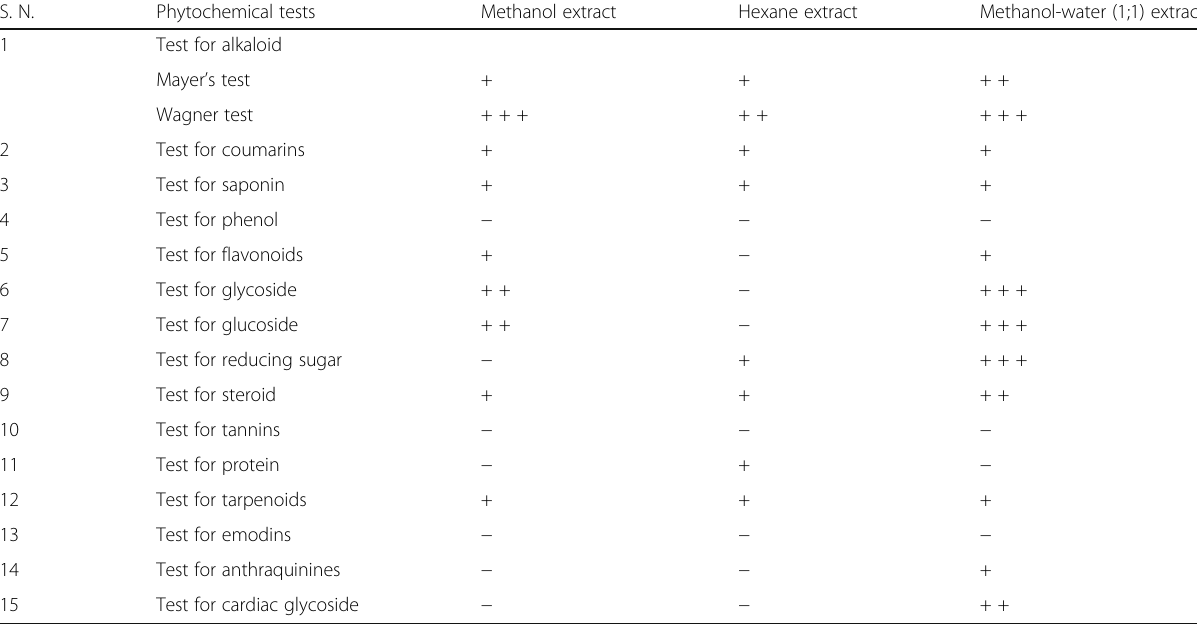
Table 1 Phytochemical composition of D. diandra in methanol, methanol-water (1:1) and hexane extract S. N.